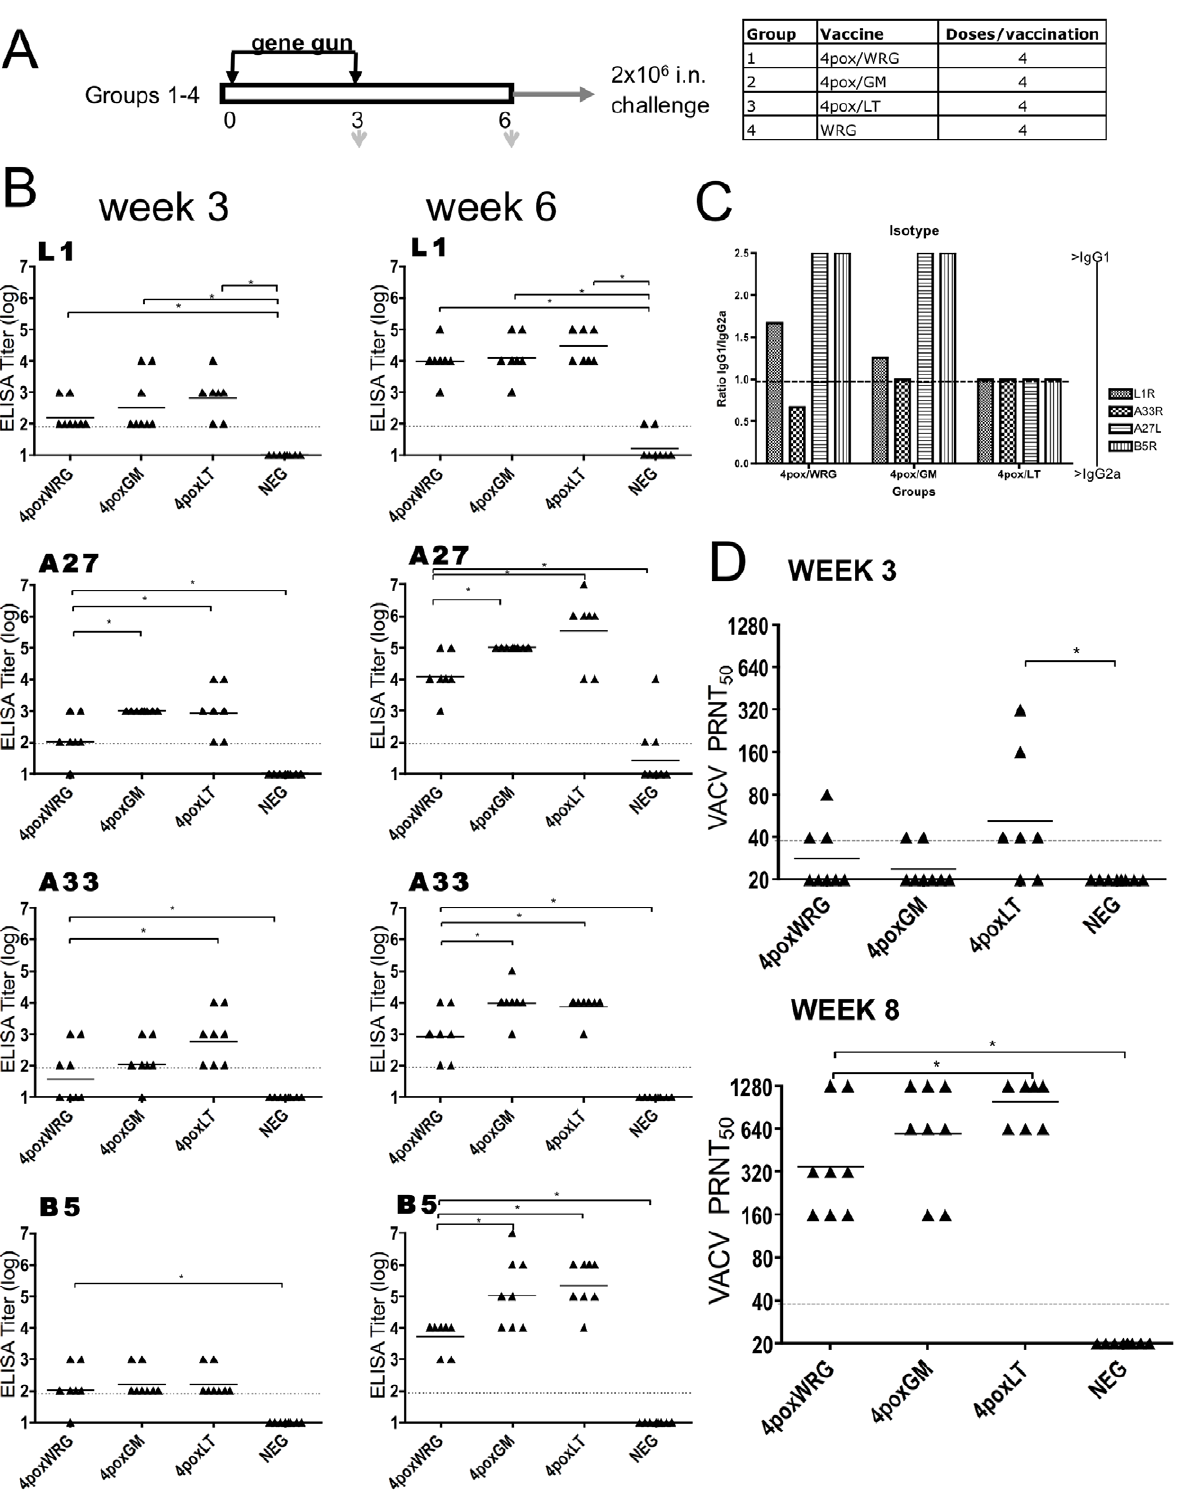
Figure 1. Antibody responses against the 4pox vaccine targets in vaccinated mice. A . Schematic showing the vaccination protocol. Mice were vaccinated by gene-gun twice at 3-week intervals with the 4pox vaccine and empty vector (4pox/WRG), 4pox plus GM-CSF (4pox/GM-CSF) or LT (4pox/LT) or a negative control vaccine containing irrelevant DNA. All mice were vaccinated with four cartridges per vaccination equaling , 2 m g DNA/vaccination. Bleed dates are indicated by the down arrows. B . Purified 4pox antigens (L1, A33, B5, and A27) were plated in 96-well plates. Sera from mice vaccinated on week 3 (prime) or week 6 (boost) with the indicated vaccines were serially diluted tenfold (from 1:100) and incubated with purified protein. Endpoint titers were calculated as described in the materials and methods. Data were plotted a scatter plot showing the distribution of the titer along with a horizontal line indicating the geometric mean titer. C . Pooled sera from vaccinated mice were serially diluted tenfold.